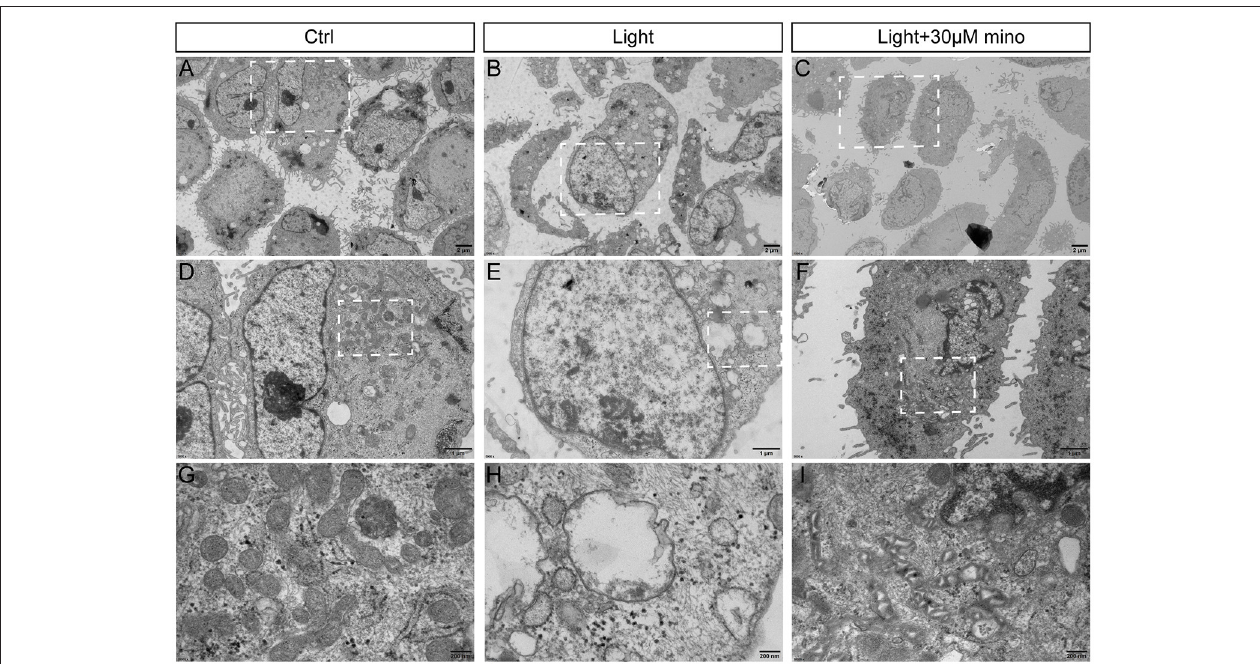
FIGURE 5 | Ultrastructure of RPE cells to show blue light damage and protective effects of minocycline via transmission electron microscopy. ARPE-19 cells were exposed to blue light for 2h and were further cultured for 2h. (A) Photomicrograph of normal ARPE-19 cells. (B) Photomicrograph of ARPE-19 cells exposed to blue light. (C) Photomicrograph of ARPE-19 cells with blue light exposure and minocycline treatment. (D–F) Enlarged parts of white dotted boxes in (A–C) . In cells of blue light group, many cytoplasmic vacuoles were observed, cell membranes were damaged, and nuclear membranes were intact. (G–I) Enlarged views of mitochondria in white dotted boxes in (D–F) . Note large number of mitochondria in normal ARPE-19 cells. In blue light group, mitochondria disappeared, and vacuoles remained. Under blue light with minocycline, mitochondria existed, but mitochondrial intermembrane space was enlarged. (A–C) Scale bar: 2 µ m. (D–F) Scale bar: 1 µ m. (G–I) Scale bar: